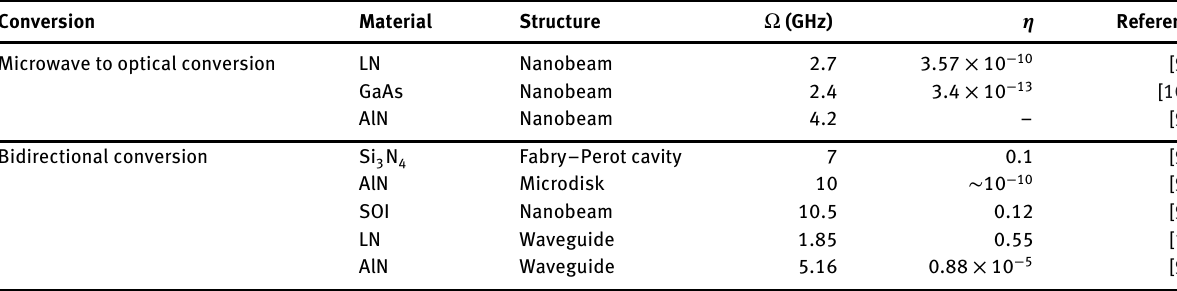
Table 2: Merit for selected experiments for microwave to optical frequency